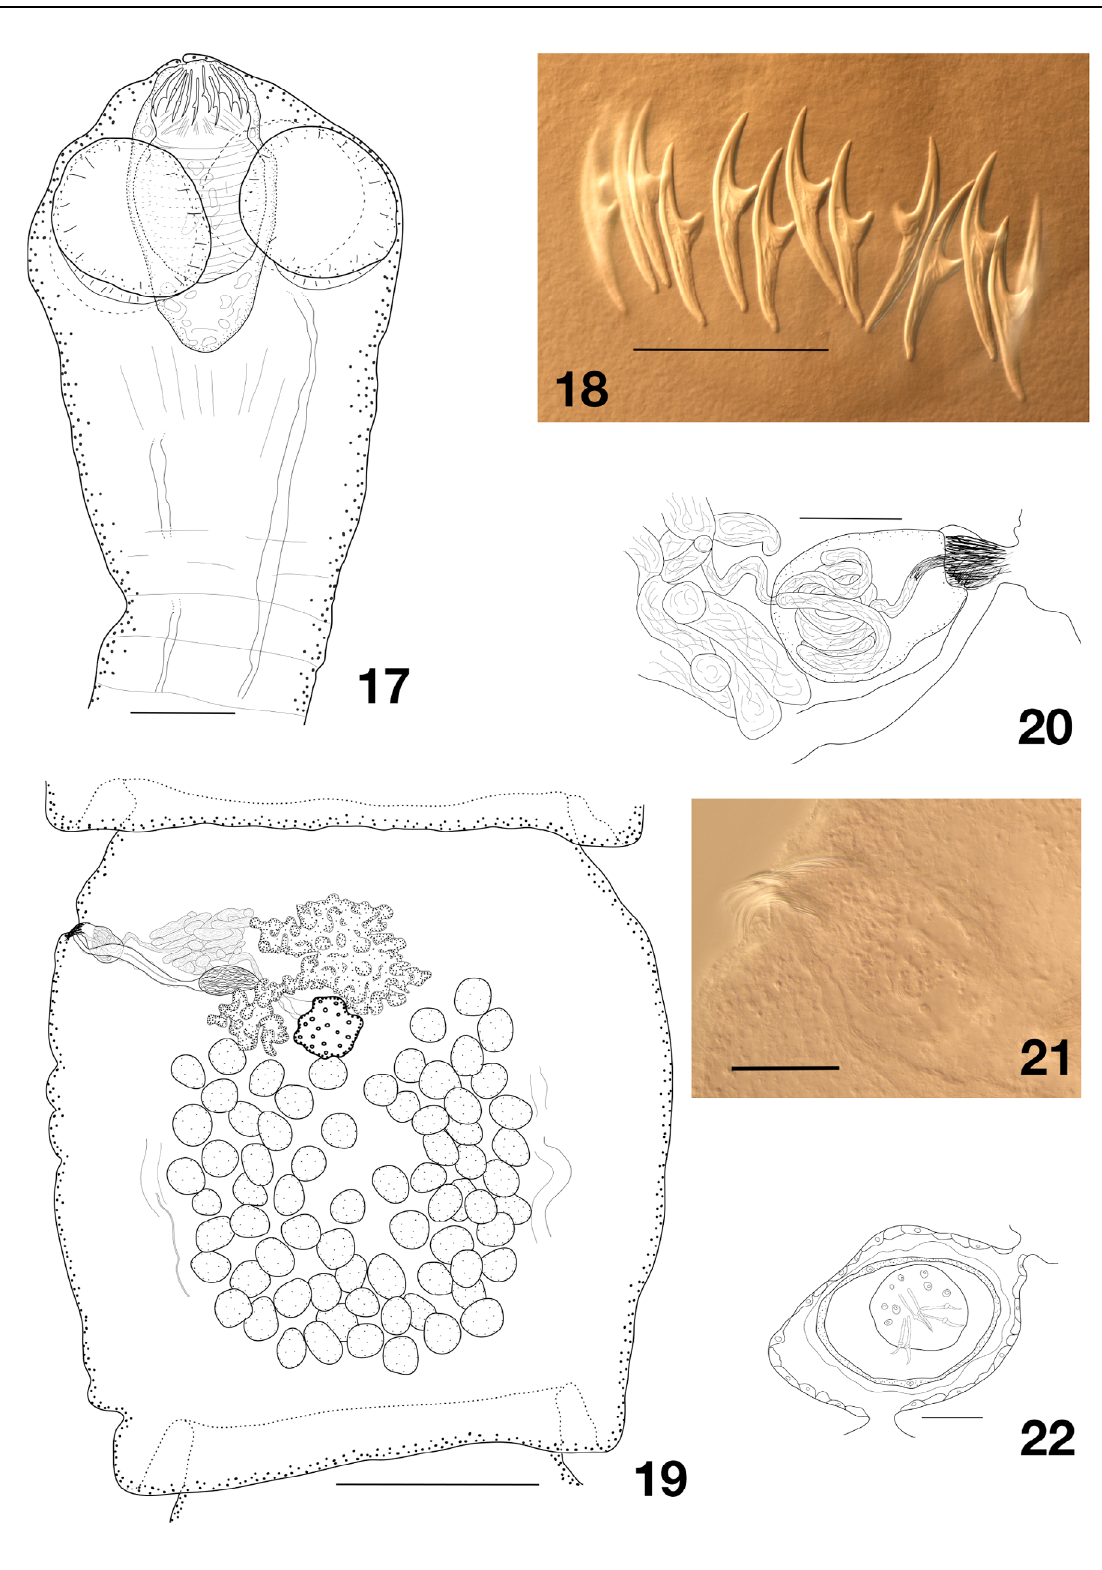
Figs 17–22. Dictymetra gerganae sp. nov. 17 . Scolex. 18 . Hooks. 19 . Mature proglottis. 20 . Terminal genitalia. 21 . Terminal genitalia tuft. 22 . Egg. Scale bars: 17 = 100 µm; 18, 20, 21 = 50 µm; 19 = 500 µm; 22 = 20